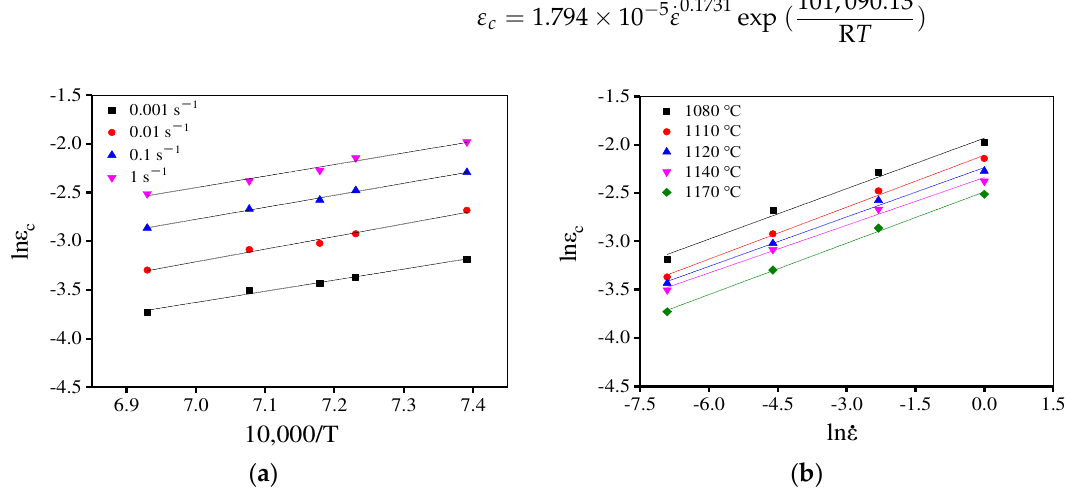
. ε ɺ . e can be obtained through the X e - drx 0.5 e at various compression condi- 0.5 e . Similarly, e is 0.5 0.5